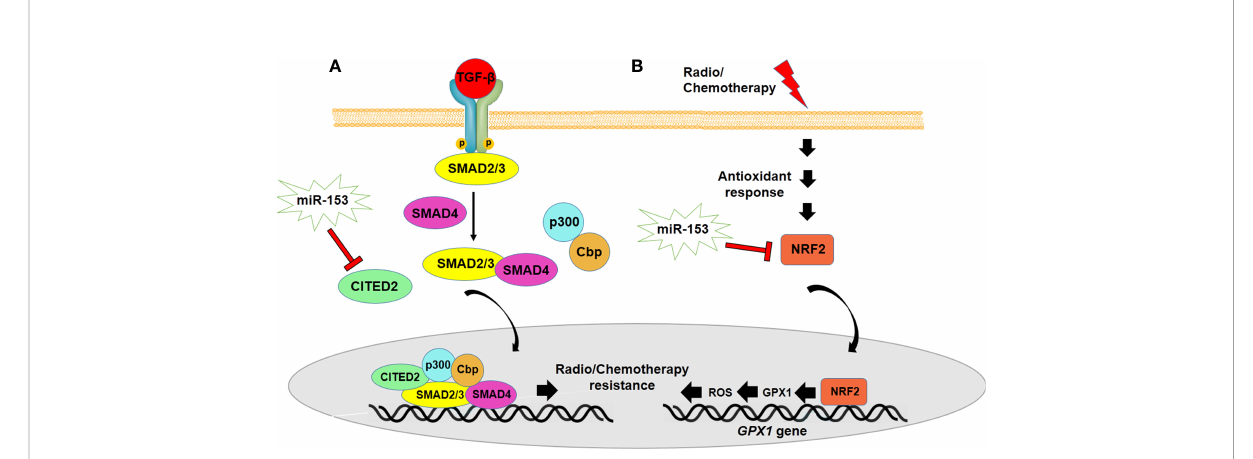
FIGURE 4 miR-153 regulates radio/chemotherapy resistance by modulating expression of CITED2 (A) and NRF2 (B) . (A) miR-153 targets CITED2 which is implicated in drug resistance of cancer cells through regulating TGF- b signaling. (B) NRF2 overexpression controls the expression of glutathione peroxidase 1 (GPX1) and reduces ROS which leads to enhancement of chemotherapy